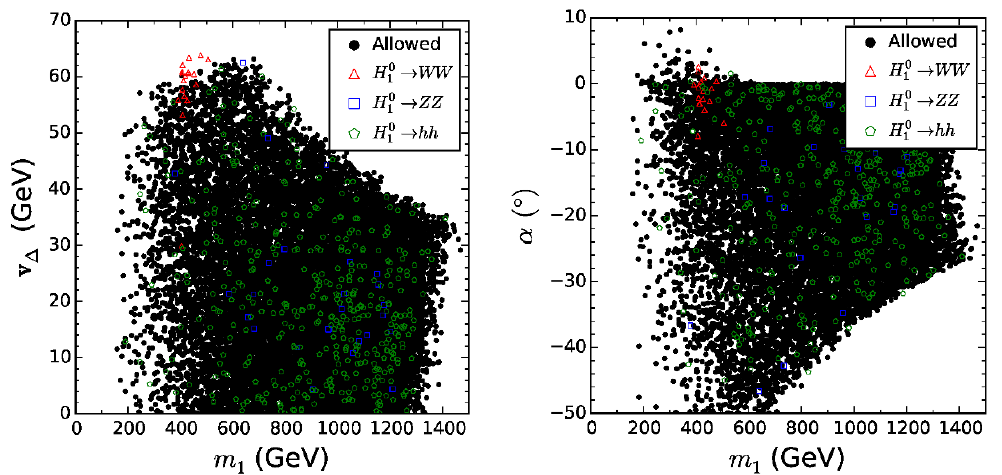
Figure 2 . Distribution of survived points shown in the v The red, blue, and green points are excluded by the H 0 with g s denoting the couplings in the SM and the GM